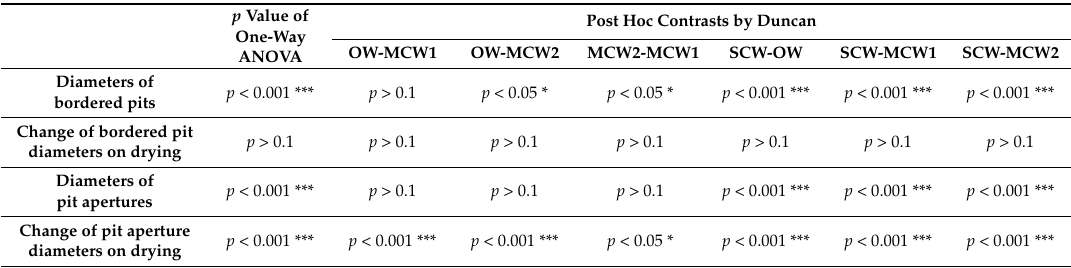
Table 5. One-way ANOVA followed by the post-hoc Duncan multiple range test set at 95% significance level of the diameters of tracheid bordered pits and their apertures in the four corewood types of Tree 1 before and after drying (100% and 10%